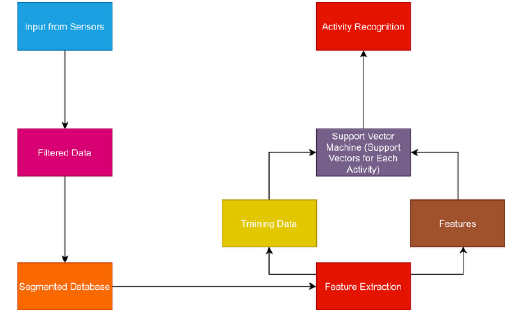
Figure 5. Basic model for SVM in order to